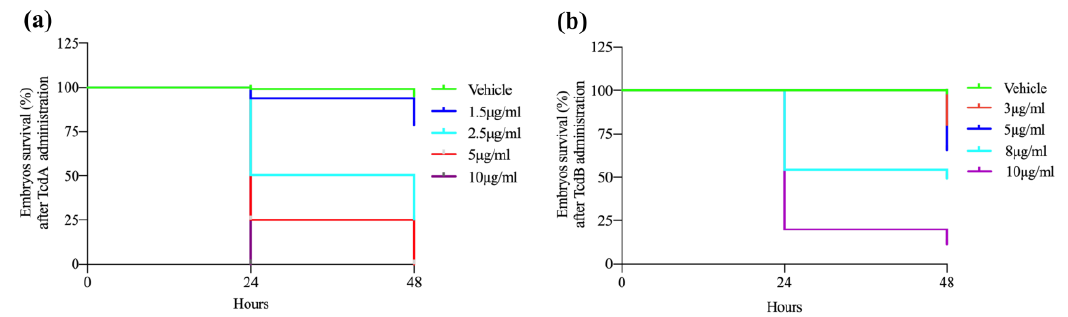
Figure 1. C. difficile toxins affect survival of zebrafish embryos. ( a ) Kaplan-Meier curve showing zebrafish embryo survival 24 and 48 h after treatment by increasing doses of TcdA (1.5, 2.5, 5 and 10 µg/mL). Data are presented as mean ± SEM. ( n = 110 for each group) ( p < 0.0001 by log-rank test). ( b ) Kaplan-Meier curve showing zebrafish embryo survival 24 and 48 h after treatment by increasing doses of TcdB (3, 5, 8 and 10 µg/mL). Data are presented as the mean ± SEM. ( n = 110 for each group) ( p < 0.0001 by log-rank test).